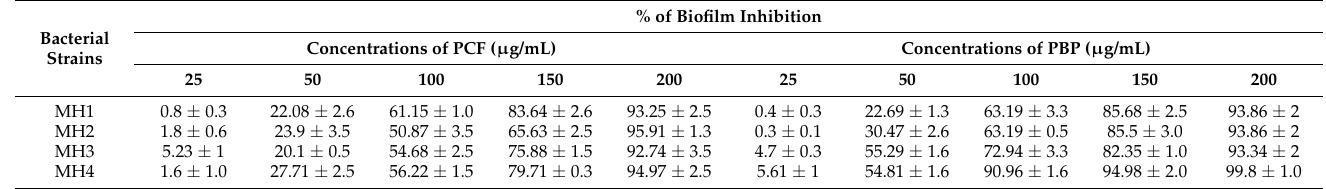
Table 4. % of the biofilm inhibition by different bacterial isolates and their combinations at various concentrations of PCF and